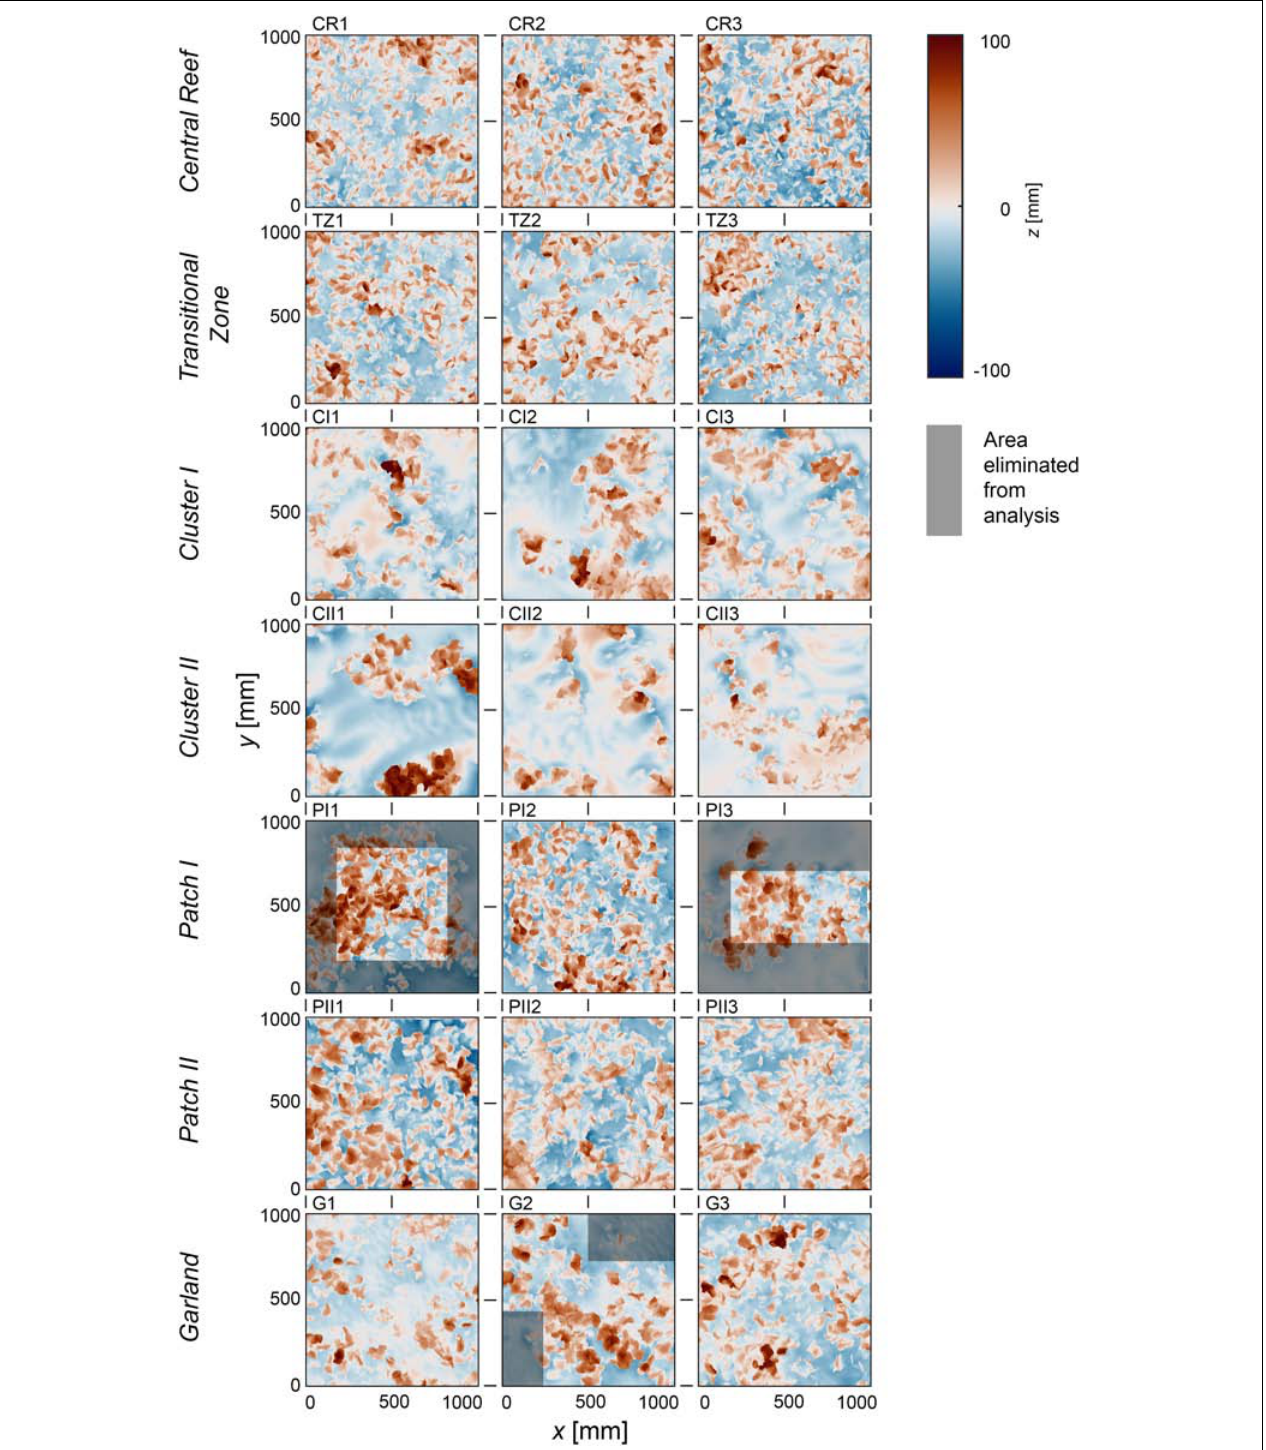
FIGURE 5 | Visualizations of the digital elevation models (DEMs) of the 21 samples in top view, sorted by proposed structural classes. The x -, y-, and z- axis are in mm. The color scale (Crameri, 2018) indicates surface level elevations in z centered around the zero mean. The point of origin ( x, y ) = (0 mm, 0 mm) has been defined as the southwest corner of the section. All samples are oriented with north on top. Area in gray boxes illustrate the areas that have been eliminated to assure homogeneous distribution of z in the analyzed section.